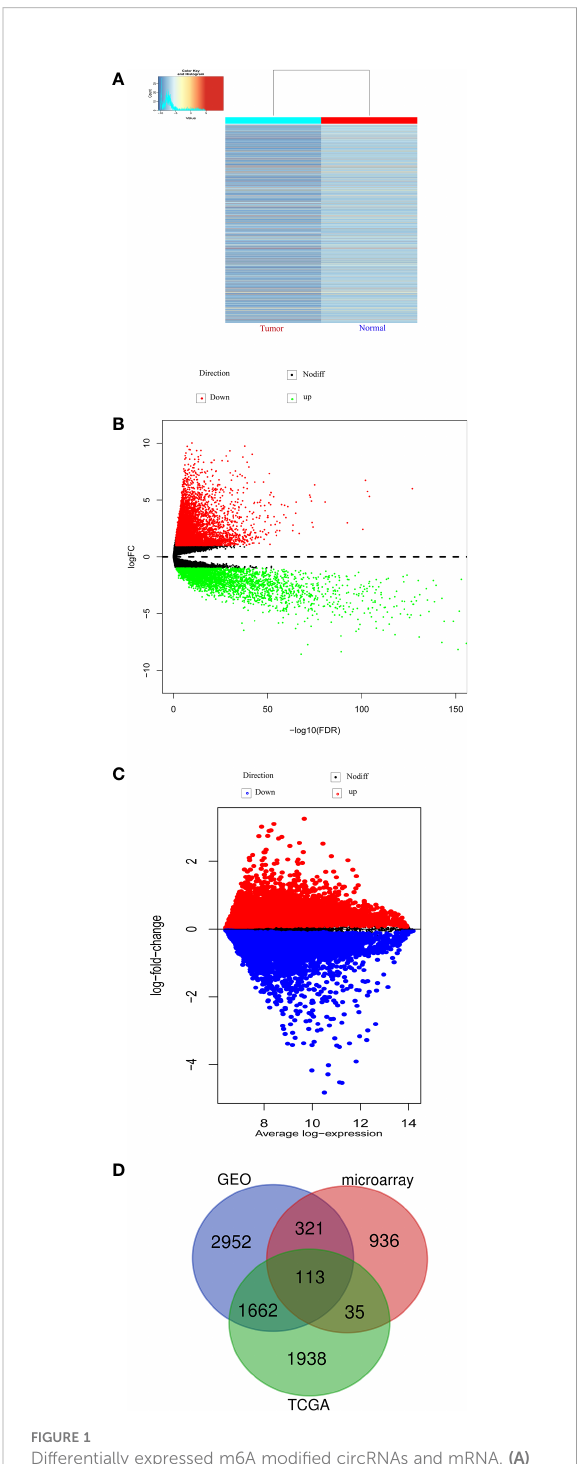
FIGURE 1 Differentially expressed m6A modi fi ed circRNAs and mRNA. (A) Hierarchical clustering heatmap of differentially m6A modi fi ed circRNAs. (B) Volcano plots of differentially mRNA based on TCGA-COAD. (C) Volcano plots of differentially mRNA based on GSE106582. (D) The intersected genes between microarray, COAD-TCGA and